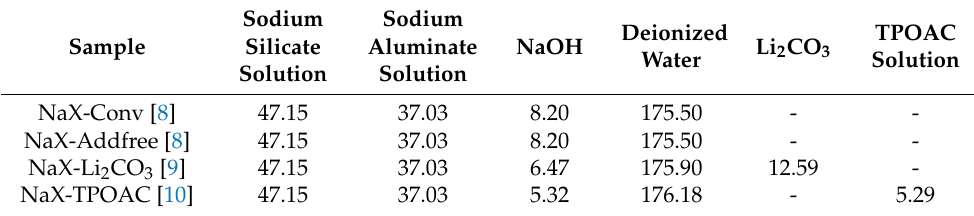
Table 5. Amount of reactants (in g) needed for each synthesis route to obtain approximately 20 g of desired